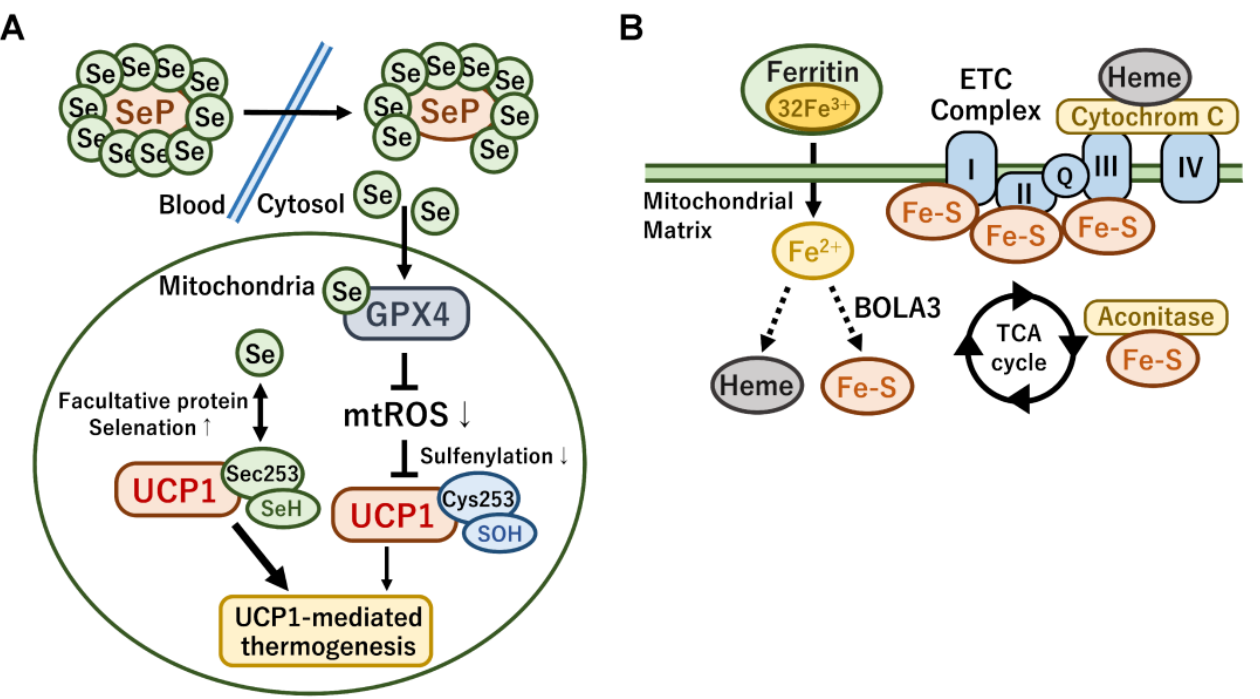
Figure 6. Selenium and iron are involved in mitochondrial energy metabolism and thermogenic capacity in thermogenic fat. ( A ) Circulating levels of selenoprotein P (SeP) are elevated under obese and diabetic conditions. Selenium molecules delivered by SeP into mitochondria activate glutathi- one peroxidase 4 (GPX4), which is a selenium-dependent antioxidant enzyme. The downregulation of mitochondrial ROS by GPX4 likely inhibits the activation of UCP1 through the sulfenylation at Cys253. In contrast, selenium is facultatively incorporated within the thiol residue of UCP1 at Cys253 to increase its activity. UCP1 with selenocysteine (Sec) is also sensitive to redox modification. Thus, selenium molecules multiply regulate UCP1 activity as well as thermogenic capacity in brown fat mitochondria. ( B ) Fe 2+ is stored by the iron storage protein, ferritin, in an unstable Fe 3+ form. In